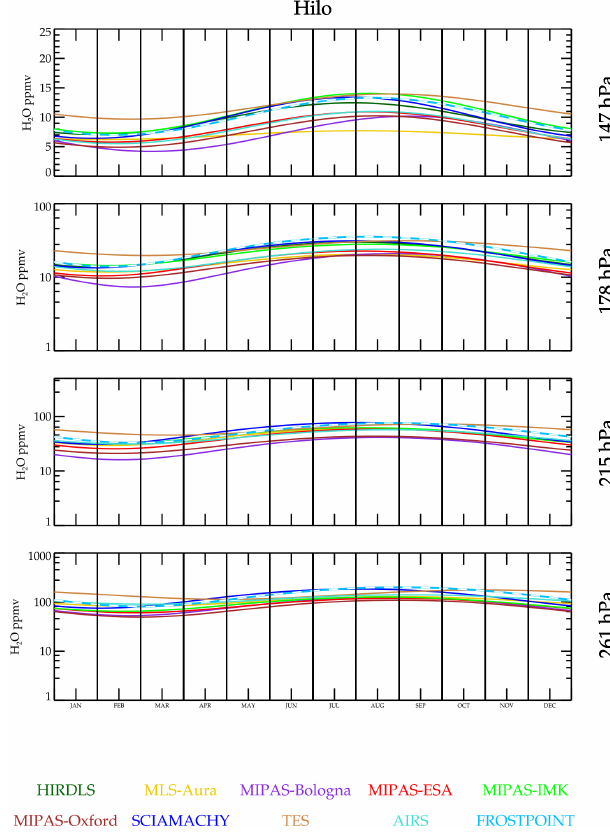
Figure 11. For each data set, a periodic 1-year function is fitted to the time series data near Boulder, CO, and plotted for 1 year. Interannual variability is averaged over for each data set. Therefore, this figure is a climatology for that data set.